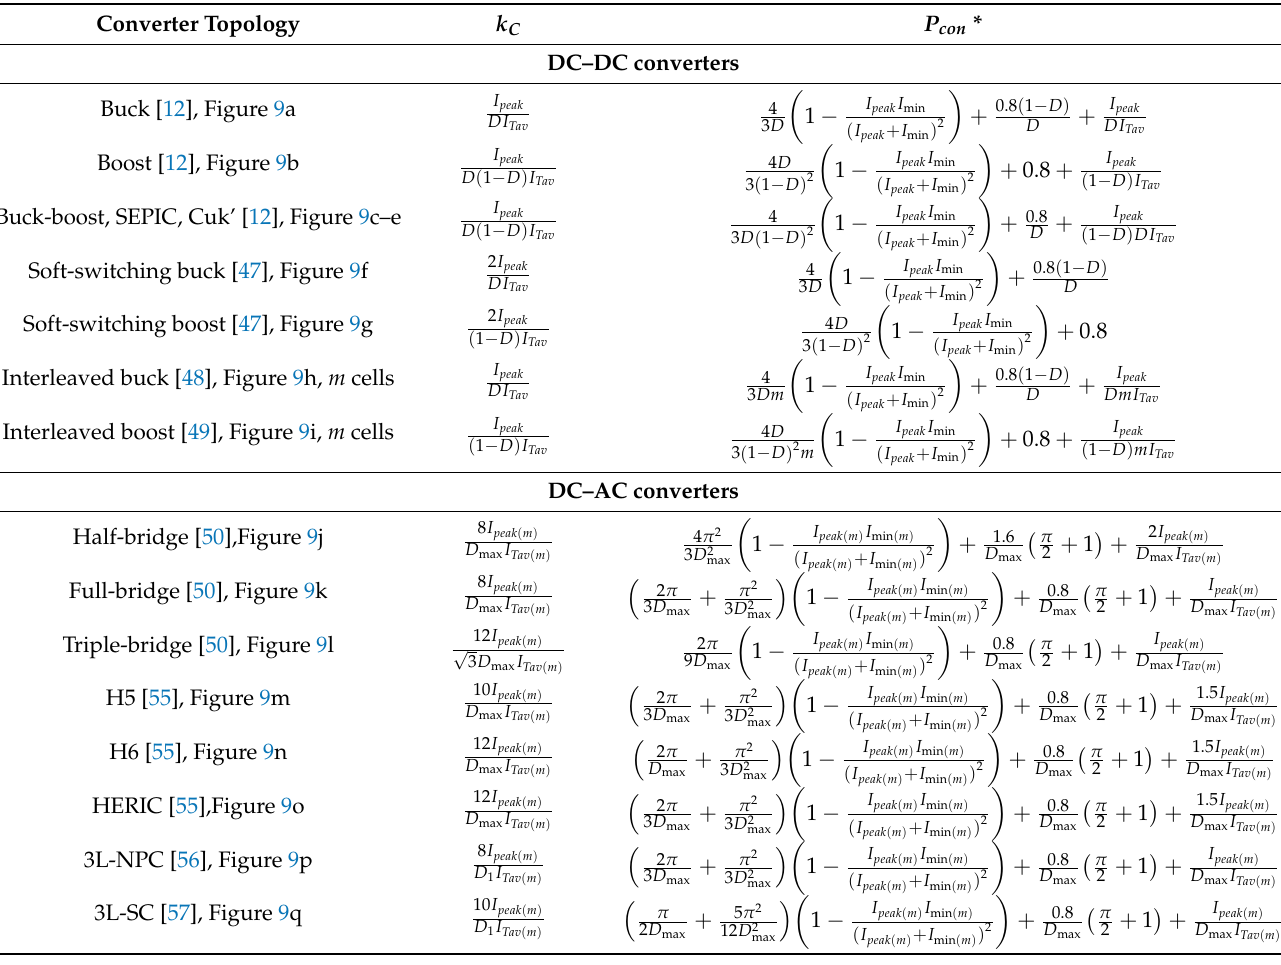
Table 3. The cost factor k C and the normalized power loss for common DC–DC and DC–AC converters. Converter Topology k